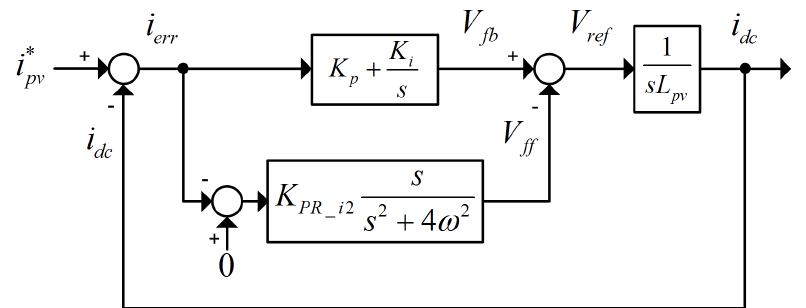
Figure 11. PI current controller with feed-forward